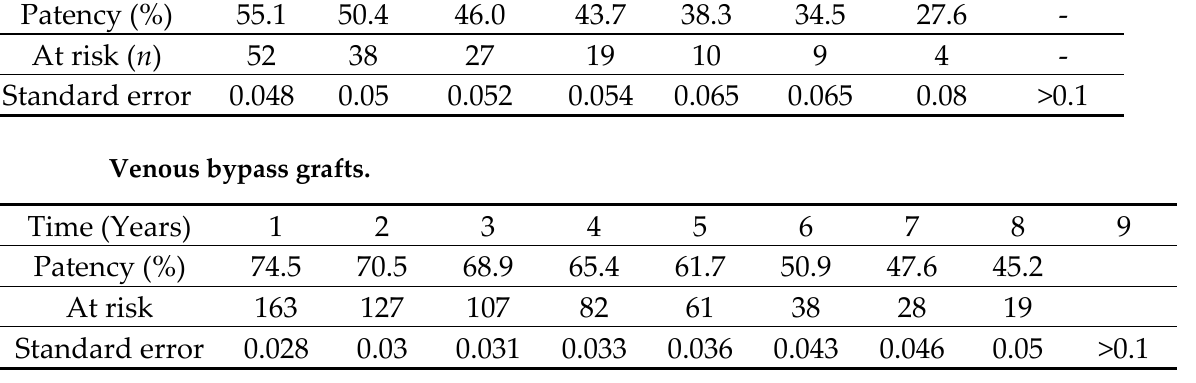
Figure 1. Comparison of the patency between prosthetic and venous bypass grafts (log-rank p < 0.001).